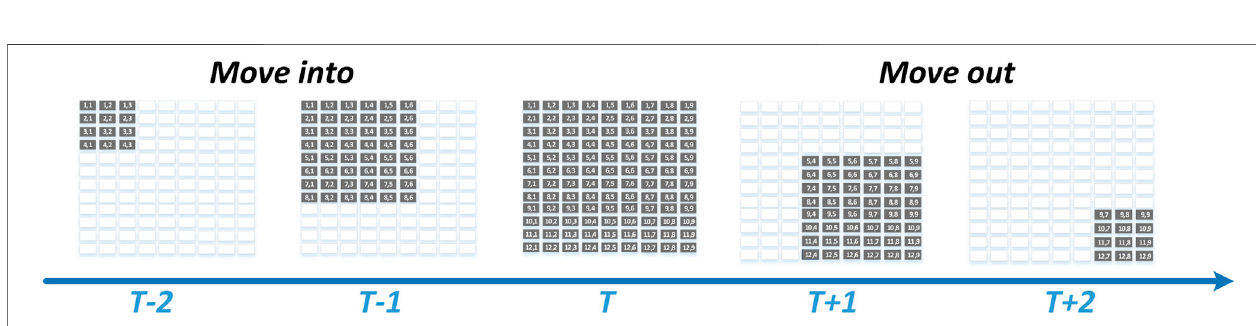
FIGURE 7 | Simpli fi ed simulation of the cloud movement for a PV